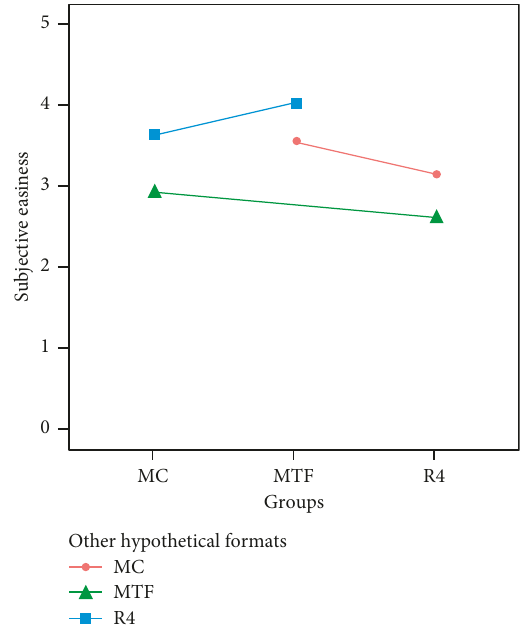
Figure 7: Year 2013 subjective evaluation. Examinees were asked to think about the other two not self-experienced keys and then to indicate how easy it would be for them to answer the same questions with such a